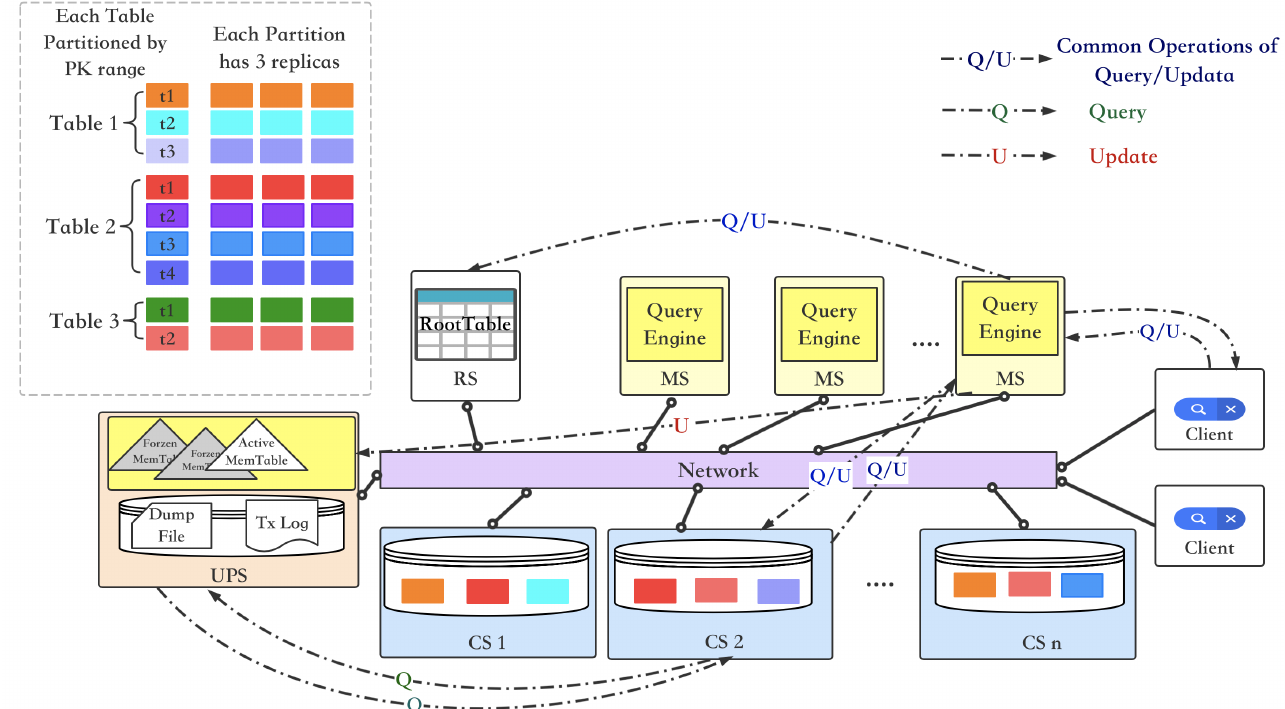
Figure 2. CBase Architecture. The CBase system includes query and updates operations. The blue markers are the same part of these two operations, the green markers are query-specific operations, and the red markers are update-specific operations. The top left corner is a schematic diagram of the database tables divided by primary key range, with warm colors representing hot partitions and cold colors representing cold partitions. However, in the original CBase system, there is no distinction between hot and cold data, and the redundant backup strategy is the